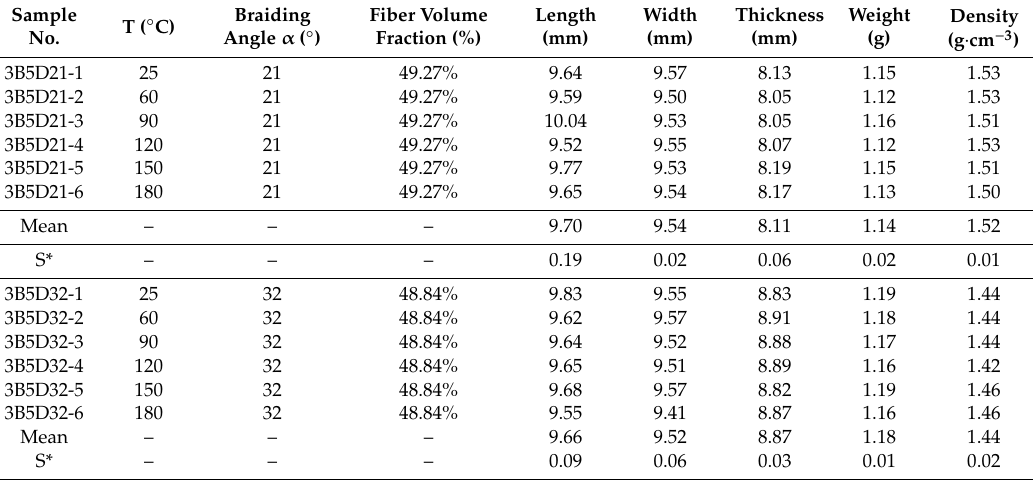
Table 1. The details of out-plane compression